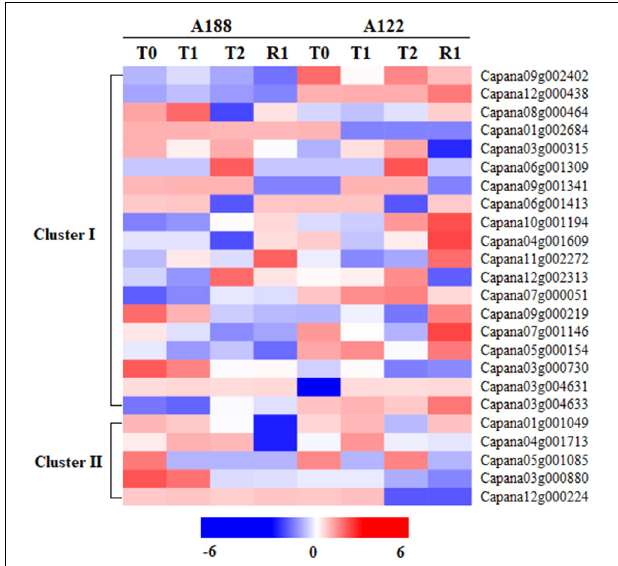
FIGURE 4 | Heat map analysis of acetylation-related proteins in proteomics under cold